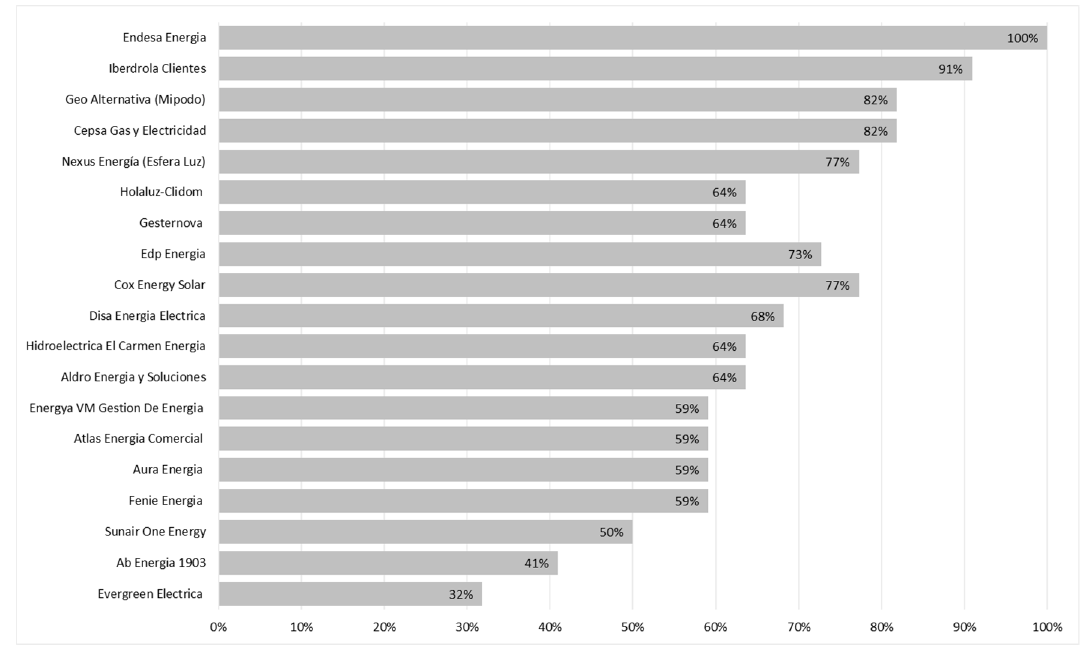
Figure 2. Digitalization of services among free-market Spanish national electricity retailers. Figure 3 details the degree of implementation of digital transformation services across free-market Spanish national electricity retailers. An analysis and discussion of the results of the analysis is detailed next.